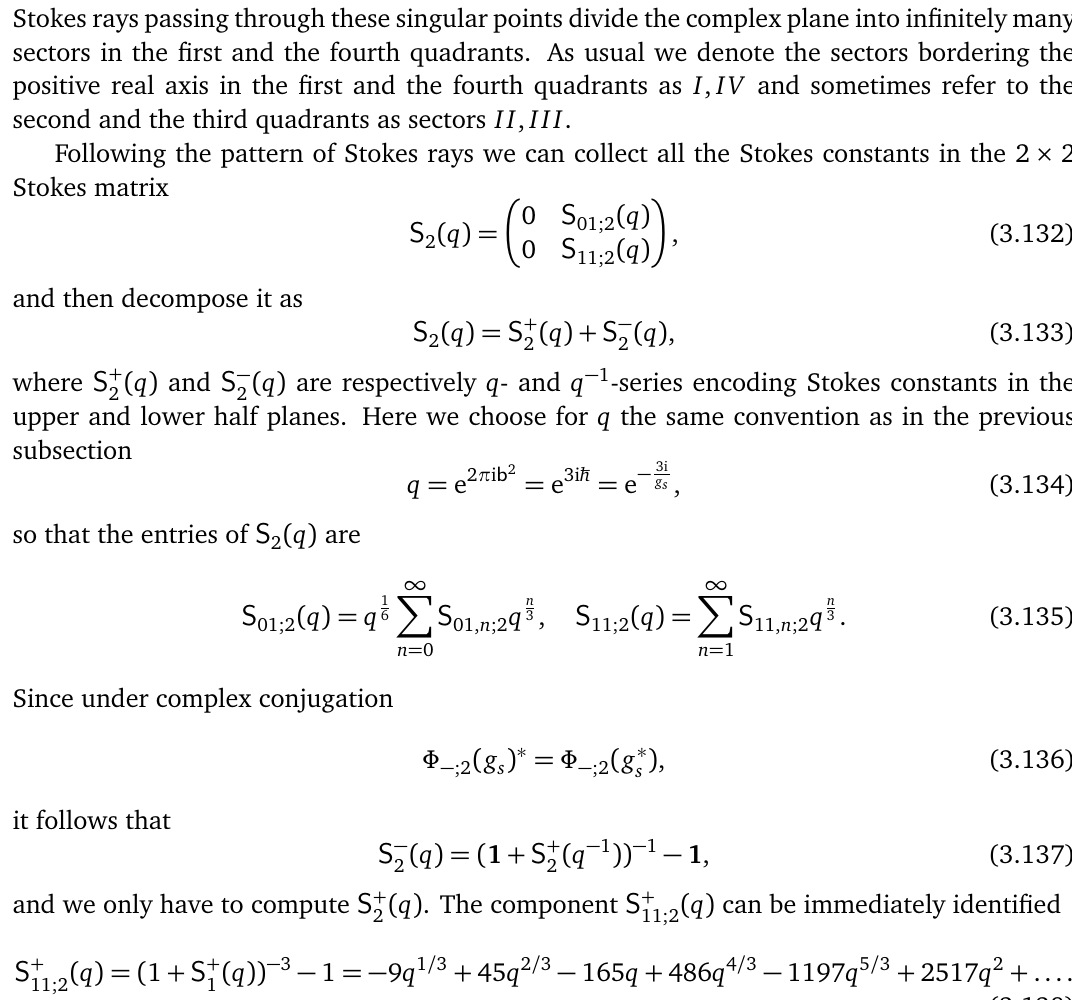
Figure 10: Stokes rays and sectors in the g the second resurgent structure of local (cid:80) 2